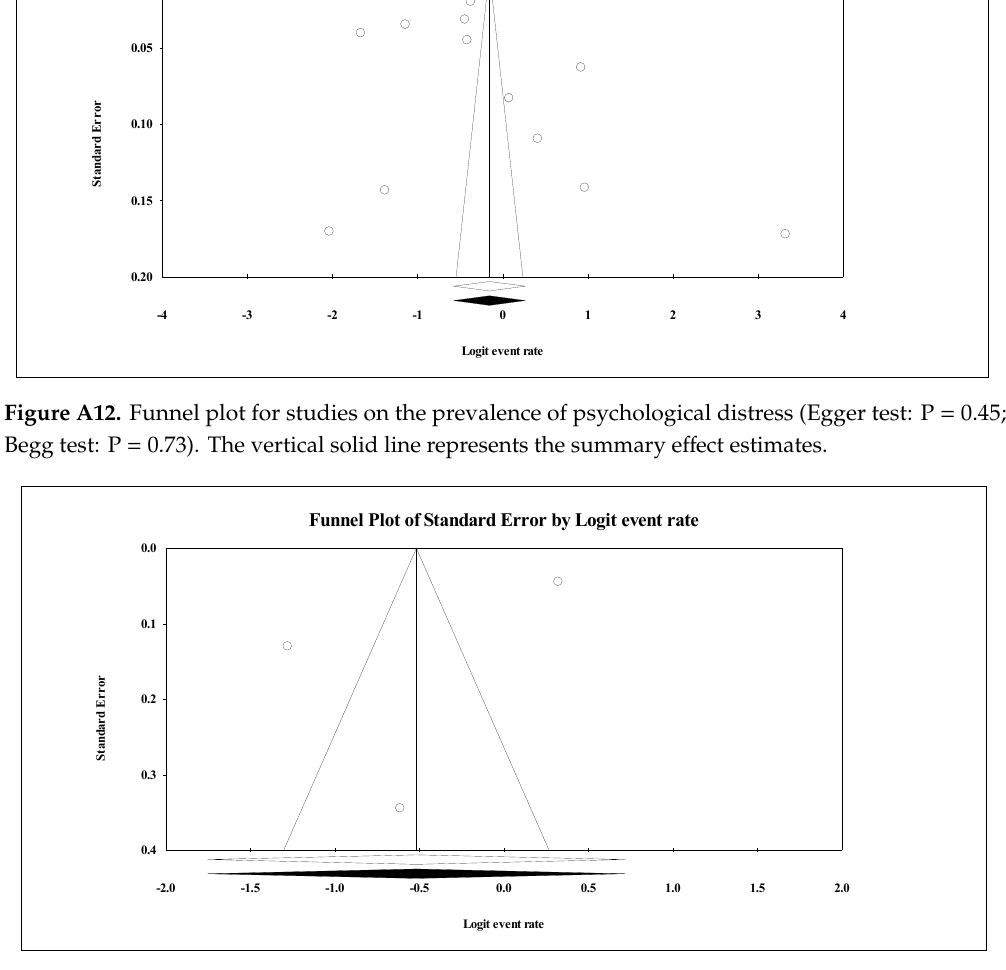
Figure A13. Funnel plot for studies on the prevalence of burnout (Egger test: P = 0.47; Begg test: P = 0.60). The vertical solid line represents the summary effect estimates.